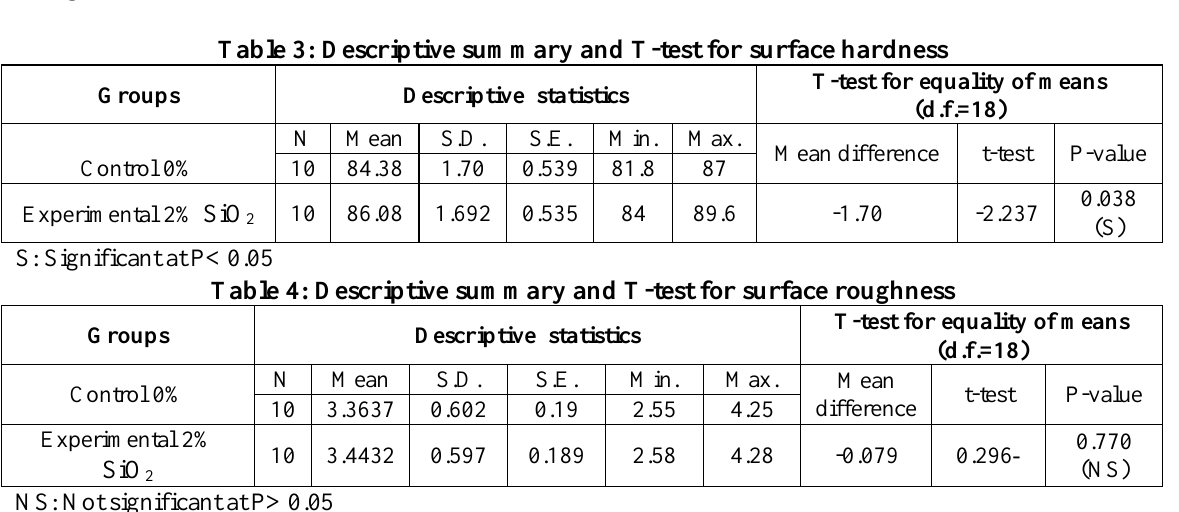
T-test for equality of means